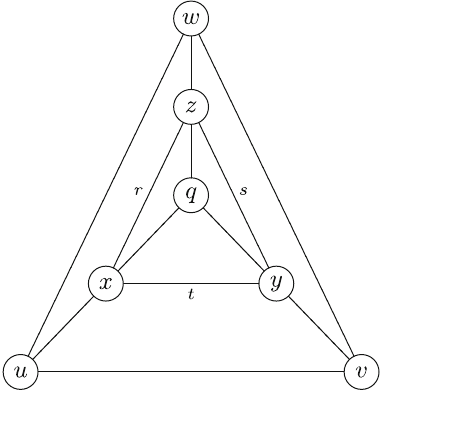
Fig. 1 The Desarguesian configuration